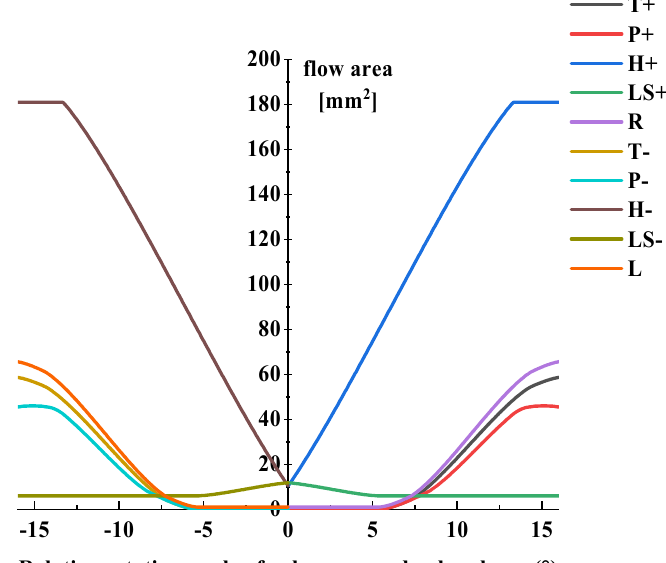
Figure 4. The flow area function of each valve port of the hydrostatic steering unit.